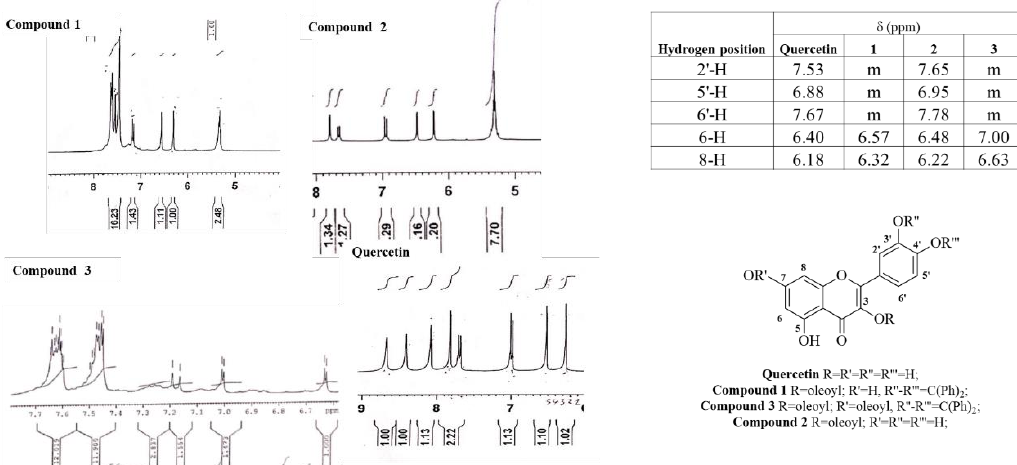
Figure 1. 1 H-NMR (300 MHz, in Acetone- d 6 ) chemical shifts of the protons of the 2-(2,2- diphenylbenzo[ d ][1,3]dioxol-5-yl)-5,7-dihydroxy-4-oxo-4 H -chromen-3-yl oleate (Compound 1 ), 2- (2,2-diphenylbenzo[ d ][1,3]dioxol-5-yl)-5-hydroxy-4-oxo-4 H -chromene-3,7-diyl dioleate (Compound